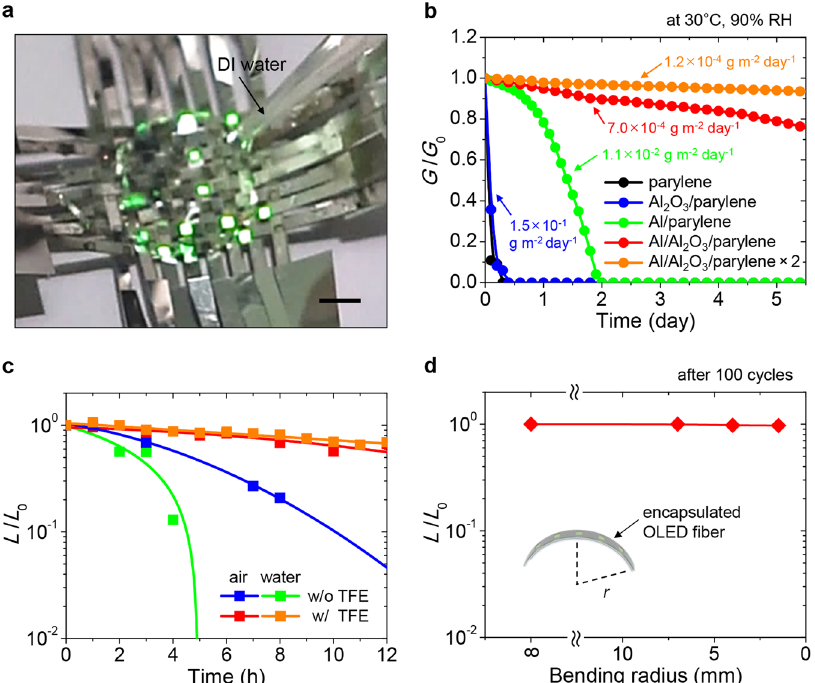
Fig. 4 Stability and deformability characteristics of encapsulated OLED fi bers. a Photograph of the operating OLED fi ber display in a DI water drop (scale bar: 5 mm). b Normalized conductance ( G / G 0 ) of the electrical Ca test samples for parylene-C (1000 nm), Al 2 O 3 /parylene-C (5/1000 nm), Al/parylene-C (100/1000 nm), Al/Al 2 O 3 /parylene-C (100/5/1000 nm), and 2-set Al/Al 2 O 3 /parylene-C (100/5/1000/100/5/1000 nm) as a function of the storing time at 30 °C and 90% RH. The evaluated WVTR values of these samples are indicated for clarity. c Measured luminance ( L ) normalized by the initial value ( L 0 ) for OLED fi ber pixels with and without TFEs stored in ambient air (23 °C, 45% RH) and DI water (23 °C) as a function of the storing time at a fi xed pixel current density of 20 mA/cm 2 . d Measured L variation normalized by the initial value ( L 0 ) for encapsulated OLED fi ber pixels after 100 times bending repetition in accordance with various bending radii at a fi xed pixel current density of 20 mA/cm 2